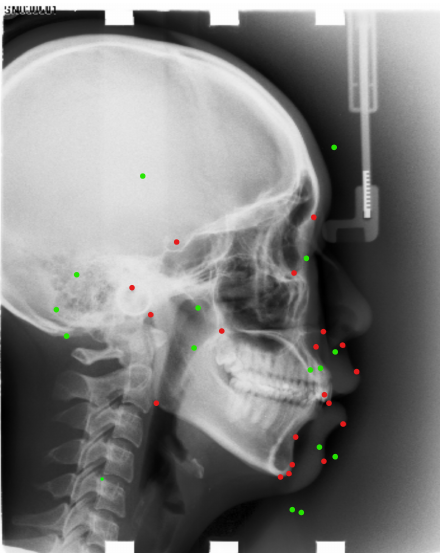
Figure 11. Green points: predicted landmarks’ locations. Red points: ground-truth locations